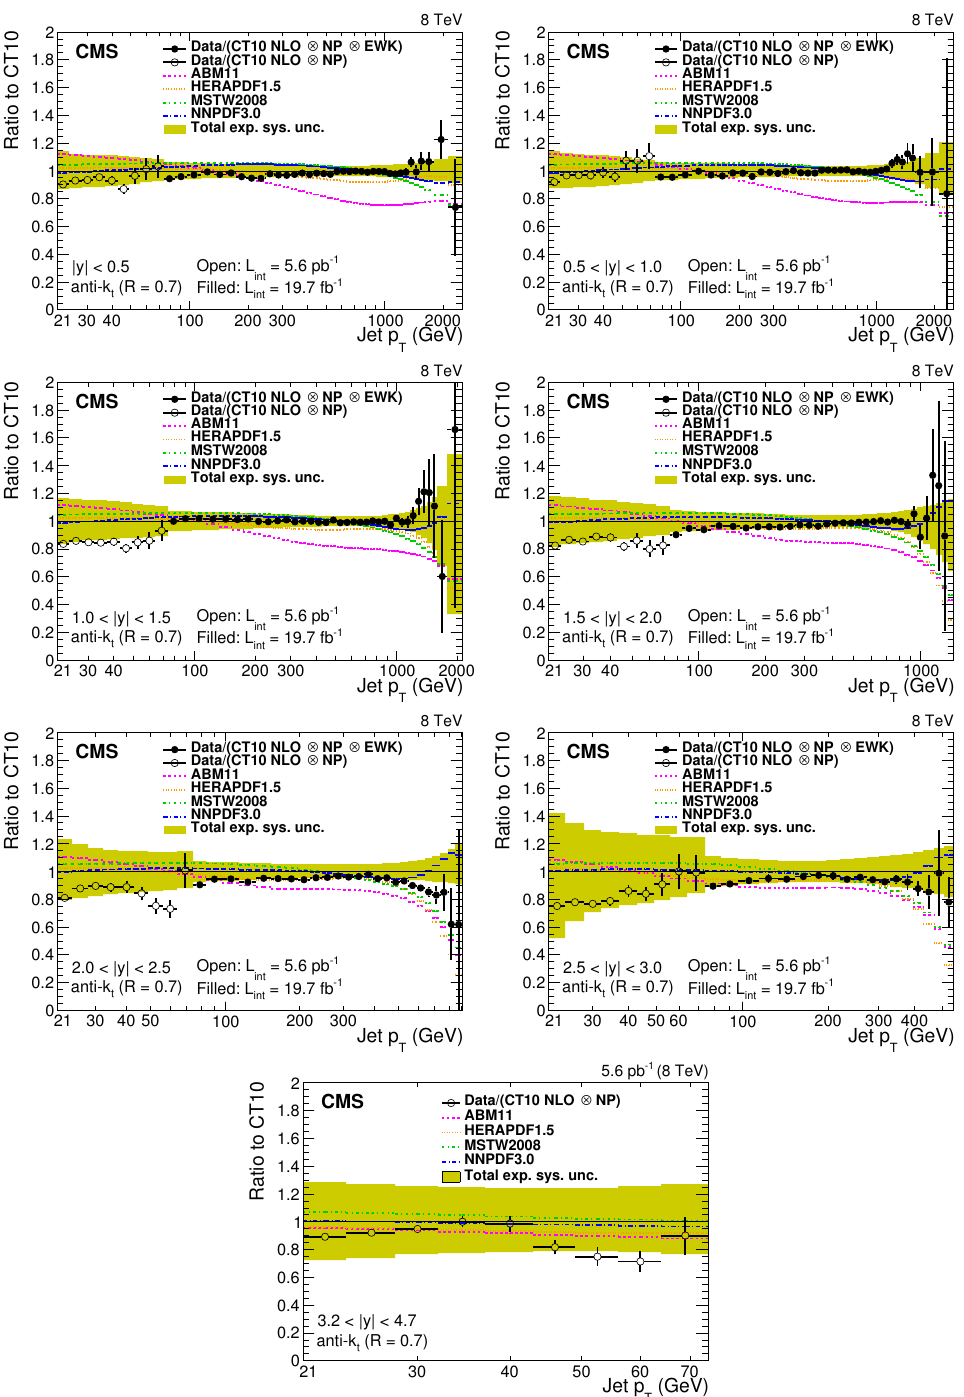
Figure 5 . Ratios of data and alternative predictions to the theory prediction using the CT10 PDF set. For comparison, predictions employing (cid:12)ve other PDF sets are shown in addition to the total experimental systematic uncertainties (band enclosed by full lines). The error bars correspond to the statistical uncertainty in the